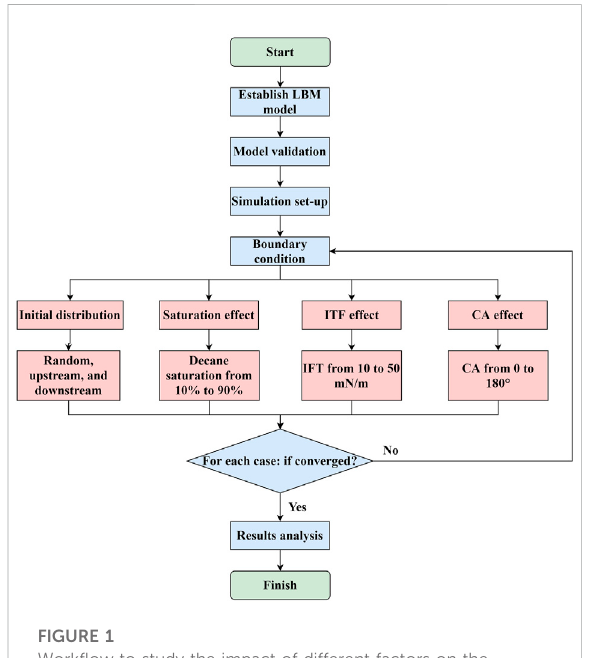
FIGURE 1 Work fl ow to study the impact of different factors on the apparent viscosity of the decane-water emulsion.